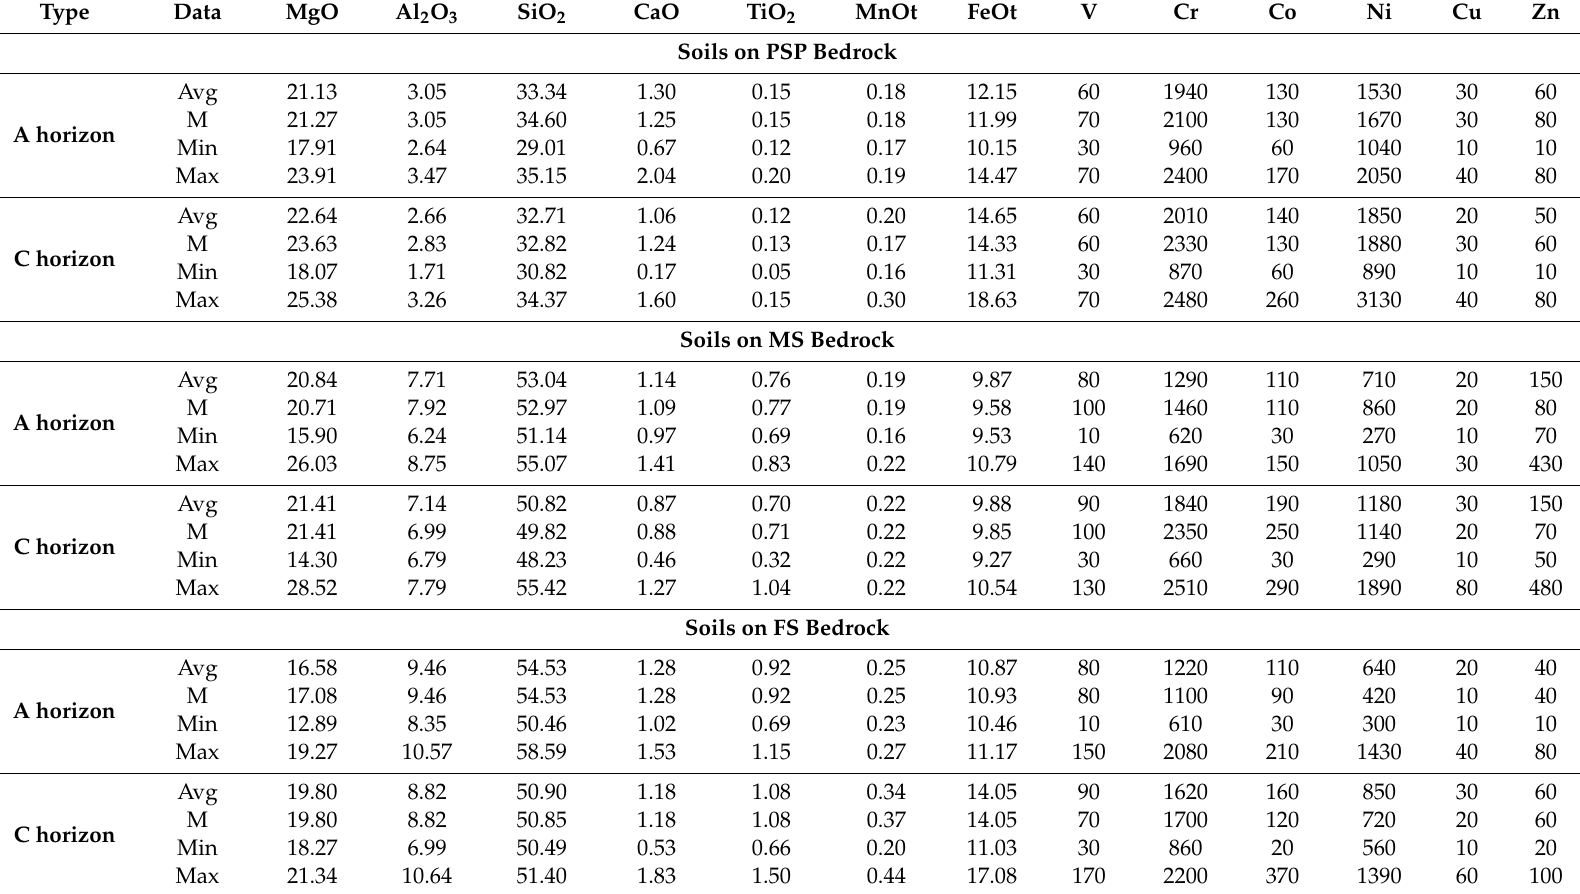
Table 2. Chemical composition of the studied soils (Avg = average; M = median; Min = minimum; Max = maximum). Major and minor elements are reported as oxide wt %; selected PTEs are reported in